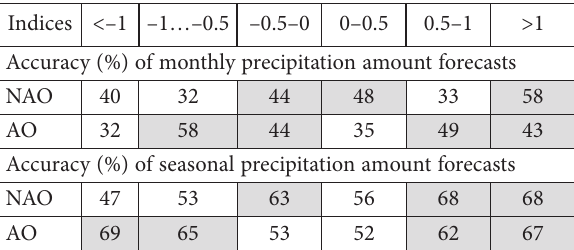
temperature and precipitation forecasts of the seasonal Table 3. Favourable/unfavourable NAO/AO indices intervals